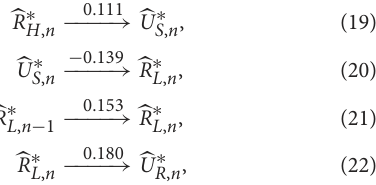
achieved for the input dataset by using the described method of probability density